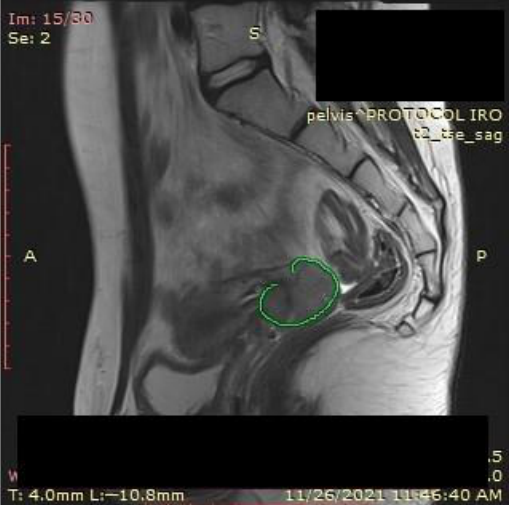
Figure 12. Favorable postradiotherapy response with the reduction in cervical mass (the green highlighted area represents the cervical tumoral mass).